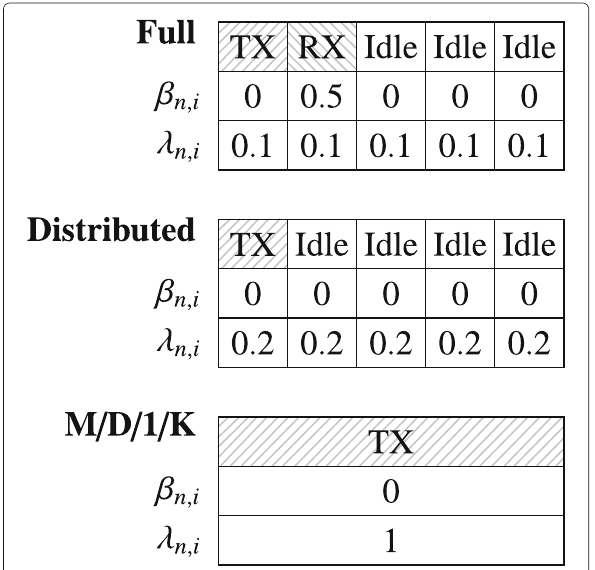
Fig. 6 Exemplary schedule for evaluating the queuing model together with two approximations, all with the same A n = 1